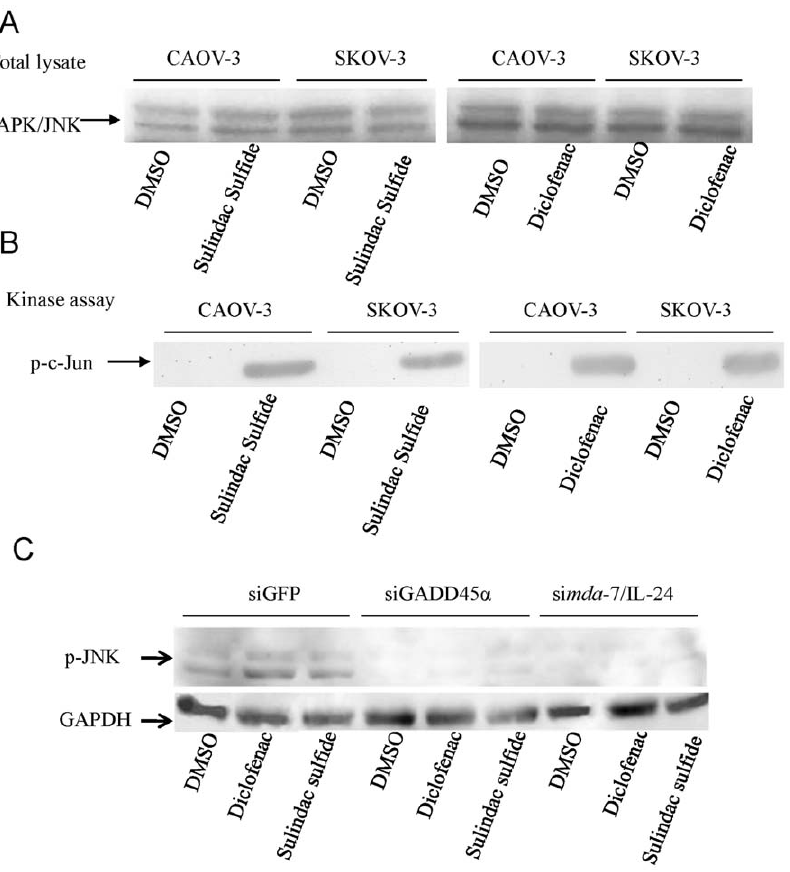
Figure 4. NSAID-treatment induces JNK activation. (A) Total lysate before Immunoprecipitation. (B) Kinase assay showing induction of JNK kinase activity by NSAIDs. Induction of JNK activation by Sulindac Sulfide and Diclofenac was analyzed in cell lysates from SKOV-3 and CAOV-3 cells treated with 50 m M Sulindac Sulfide, 100 m M Diclofenac or DMSO using the SAPK/JNK assay Kit (Cell Signaling). (C) Western Blot analysis using anti-phospho JNK antibody of cell lysates from CAOV-3 cells treated with 50 m M Sulindac Sulfide, 100 m M Diclofenac or DMSO and infection with lentivirus encoding mda -7/IL-24 siRNA, GADD45 a and GFP duplexes.